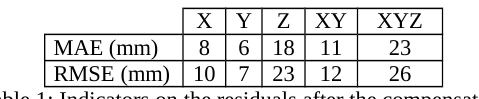
Table 1: Indicators on the residuals after the compensation When we interpolated the computed model at the GCP emplacements, we observed a sort of bending on the extremities of the site. Figure 4 shows that this bending effect can bring errors over 10cm on the edges.